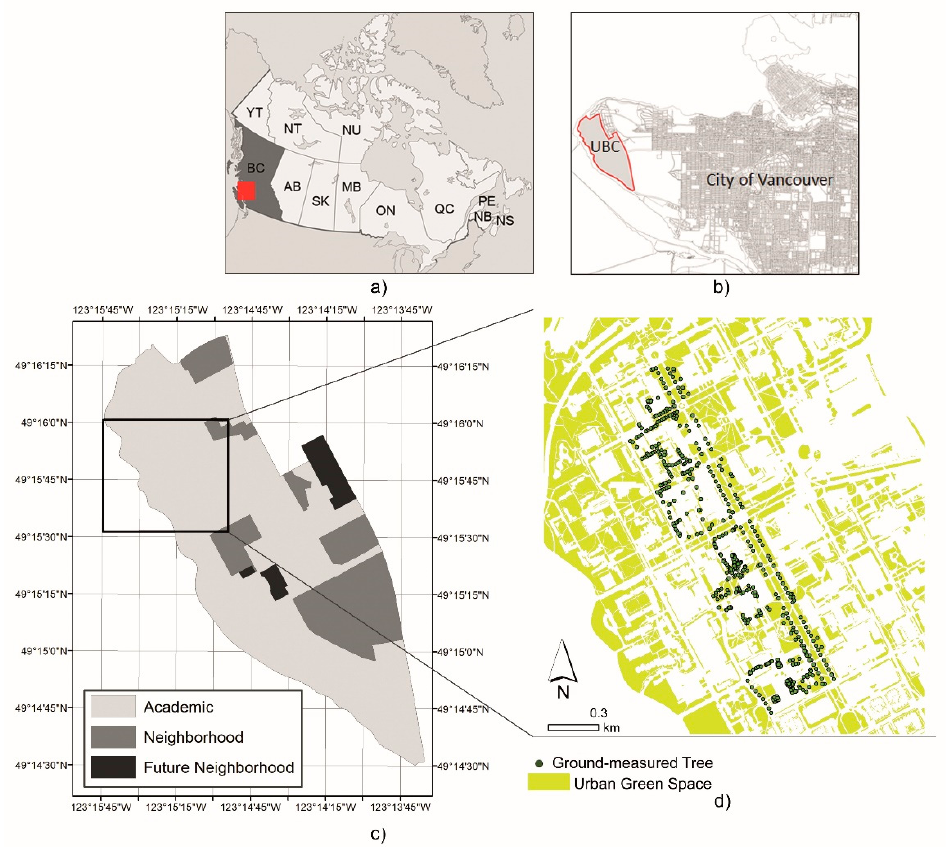
Figure 1. ( a ) Provinces of Canada; ( b ) geographical location of study area (University of British Columbia (UBC) Point Grey campus); ( c ) land use of UBC; ( d ) the specific survey area.